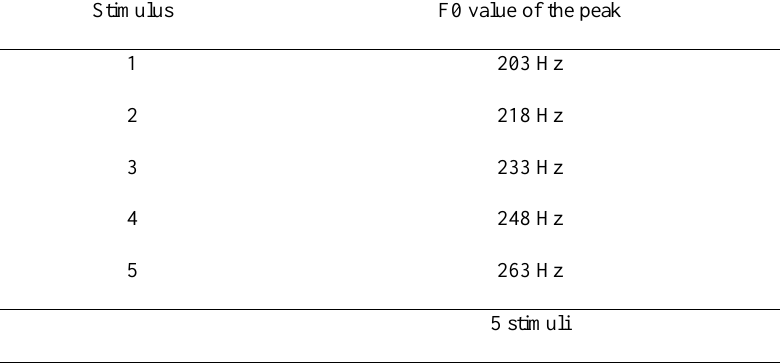
(presented in blocks of 10 in random order). Table I. Stimuli for the identification